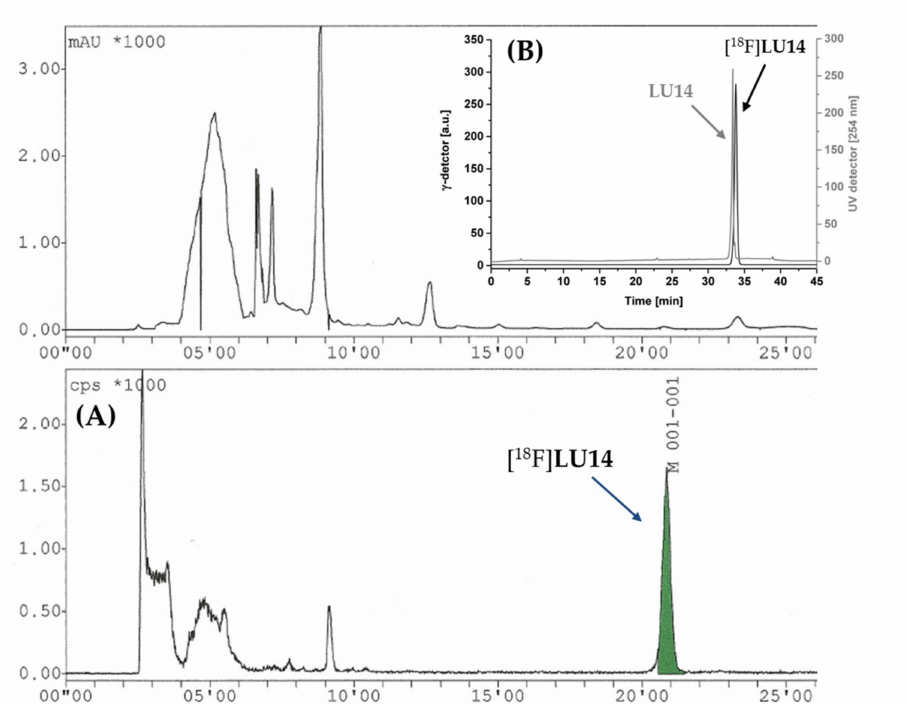
Figure 3. ( A ) Representative semi-preparative radio-HPLC profile of [ 18 F] LU14 (Conditions: Reprosil- Pur 120 C18-AQ (5 µ m, 250 × 10 mm), 65% CH 3 CN/20 mM NH 4 OAc aq., 4.2 mL/min) and ( B ) analytical UV- and radio-HPLC chromatogram of [ 18 F] LU14 (solid line, G -trace) spiked with the corresponding reference compound LU14 (grey line, UV-trace); conditions: Reprosil-Pur C18-AQ (5 µ m, 250 × 4.6 mm), 70% CH 3 CN/20 mM NH 4 OAc aq., 1 mL/min. mAU = milli-absorbance unit; cps = counts per second.